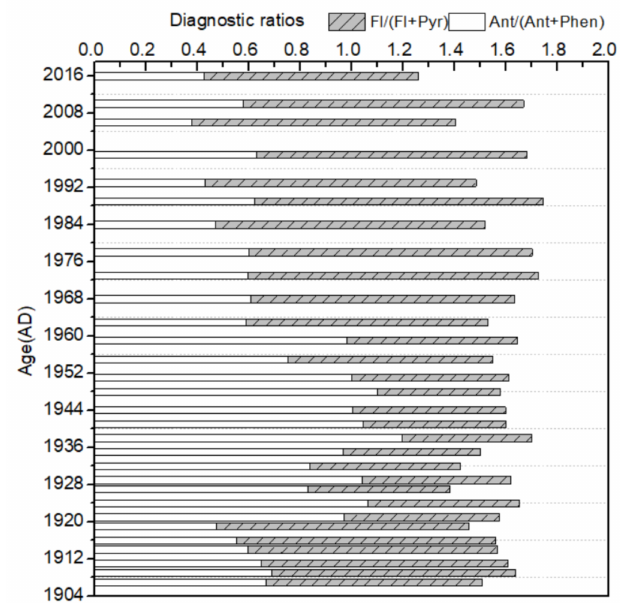
Figure 4. Diagnostic ratios of polycyclic aromatic hydrocarbon (PAH) ratios in the sediment core of Dongping